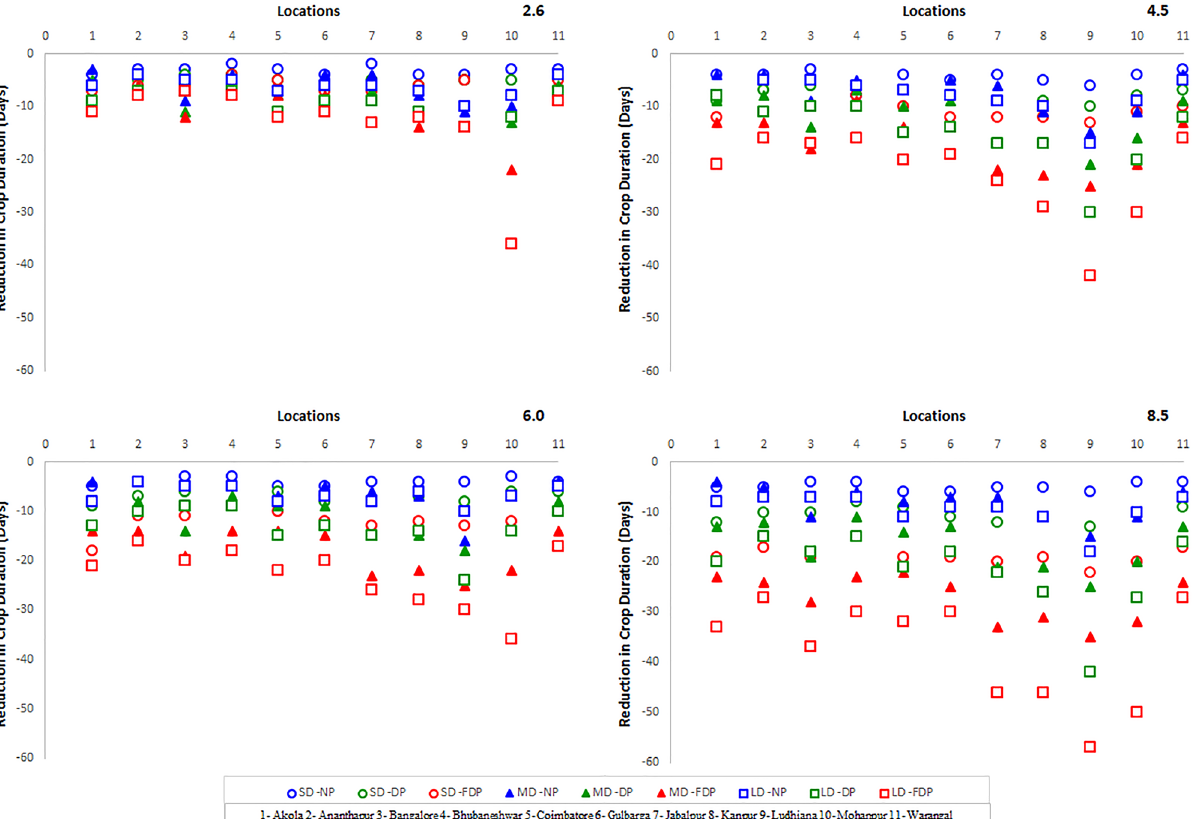
Figure 8. Alteration of duration of 3 pigeonpeas based on GDD across four RCP and 3 CCPs across 11